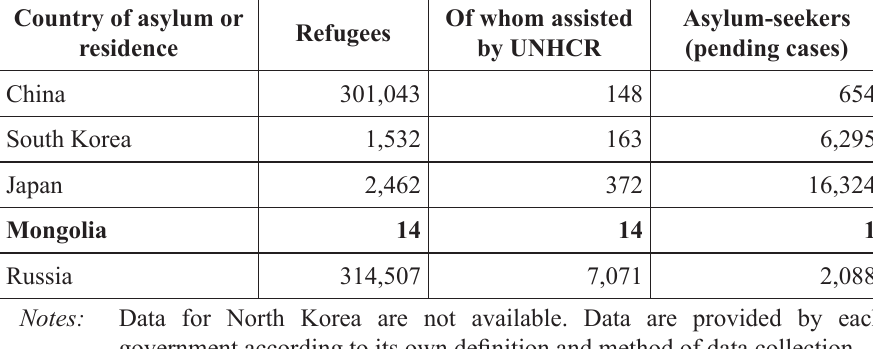
Table 2. Refugees and asylum seekers by country/territory of asylum, mid-2016 Country of asylum